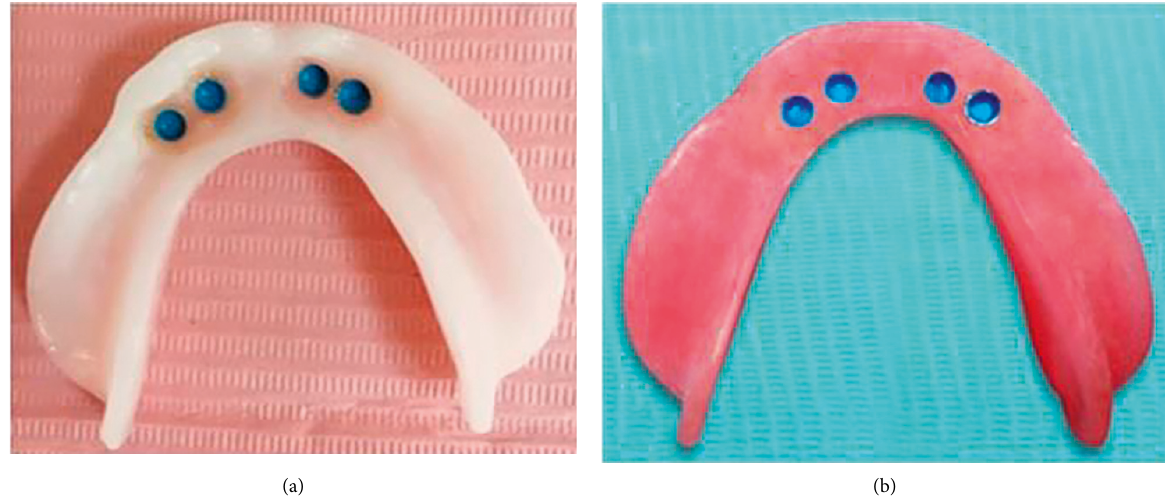
Figure 5: (a) Fitting surface of CAD-CAM milled mandibular overdentures with picked up attachments. (b) Fitting surface of conventional, compressed mold technique, constructed mandibular overdentures with picked up